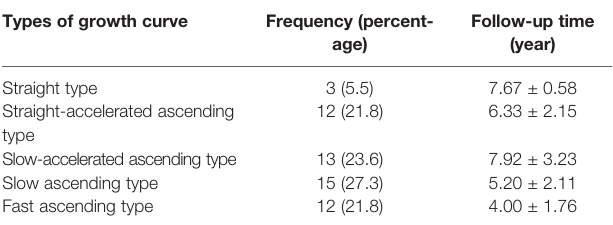
TABLE 2 | Different types of growth curves and corresponding follow-up